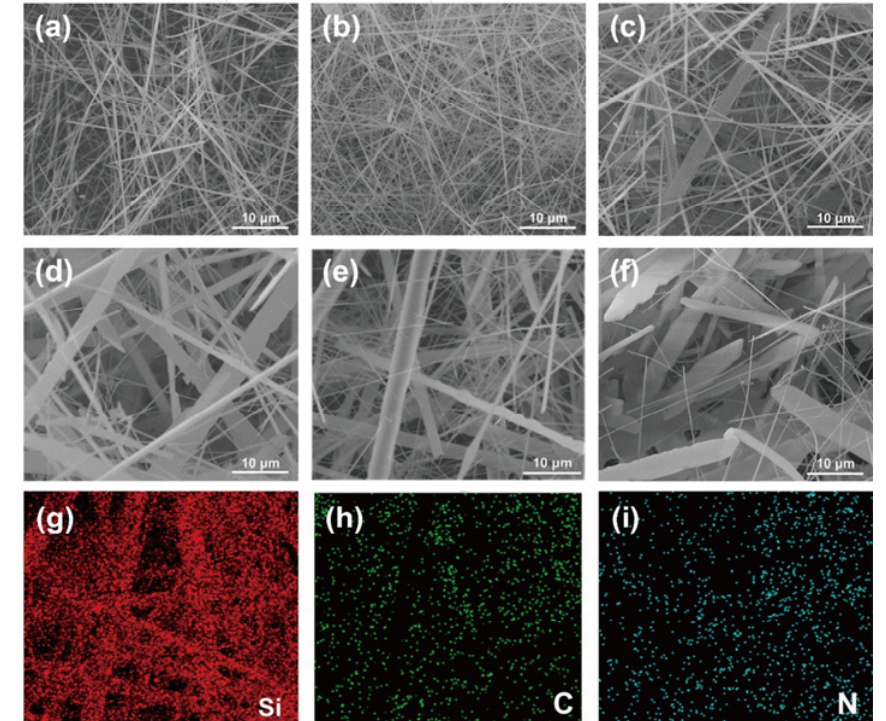
Fig. 3 SEM images of (a) pure SiC aerogel, (b) S1, (c) S2, (d) S3, (e) S4, and (f) S5. EDS mapping images of S4 correspond to (g) Si, (h) C, and (i) N